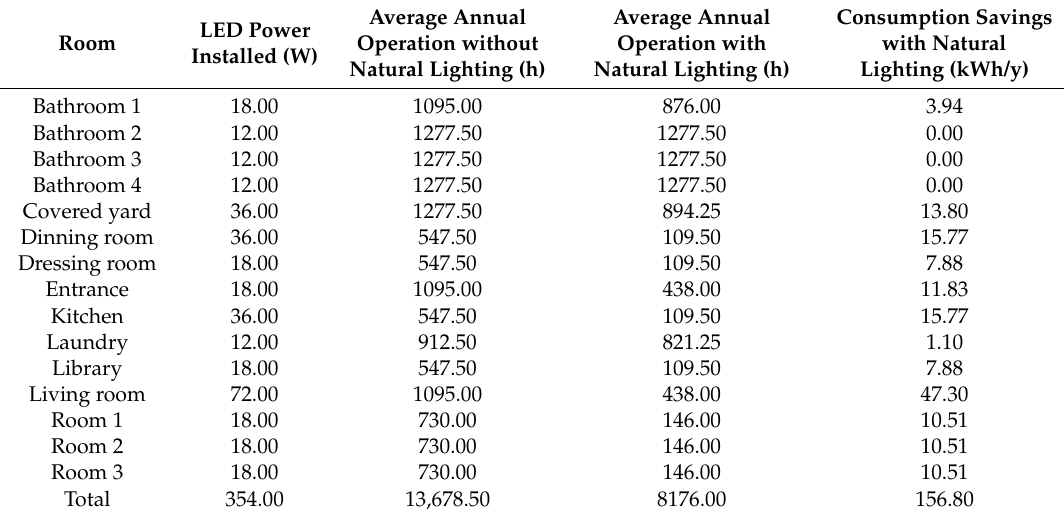
Table 2. Savings due to natural lighting in Casa Zaranda. The comparison that can be made regards installed LED